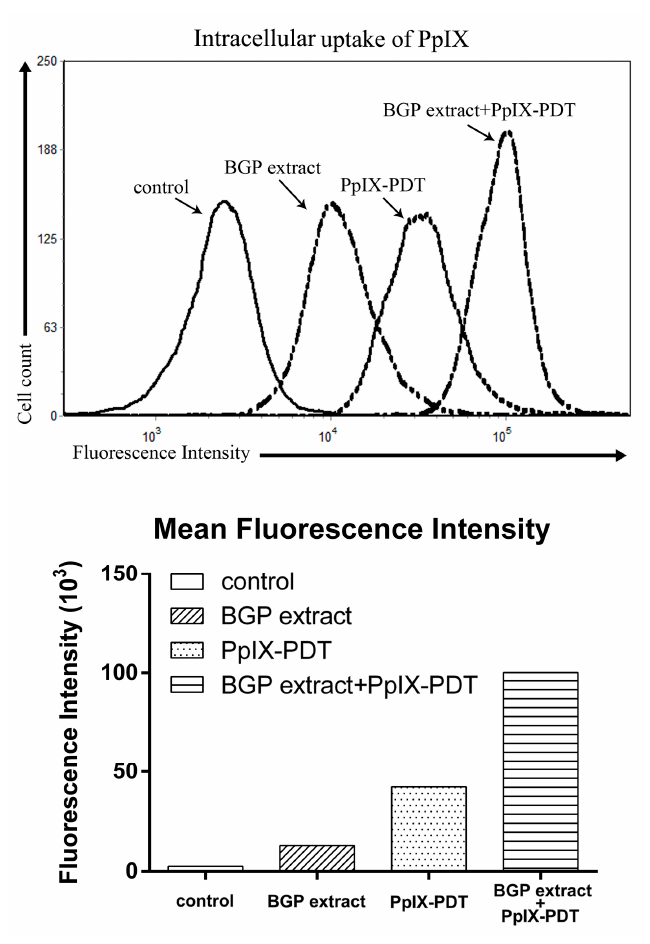
Figure 7. Intracellular accumulation detection of protoporphyrin IX (PpIX) by flow cytometry. Mean fluorescence intensity was measured by a BD Accuri TM C6 flow cytometer.